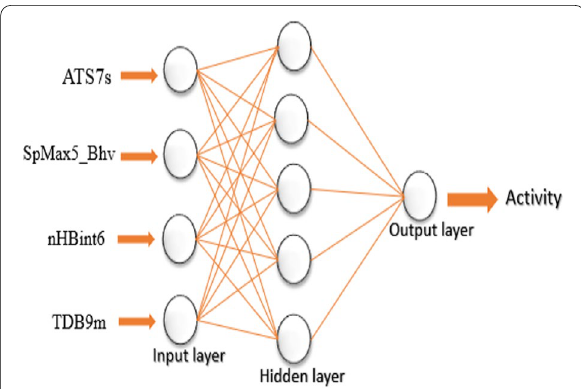
Fig. 2 Schematic representation of the GFA-ANN (4-5-1) architecture